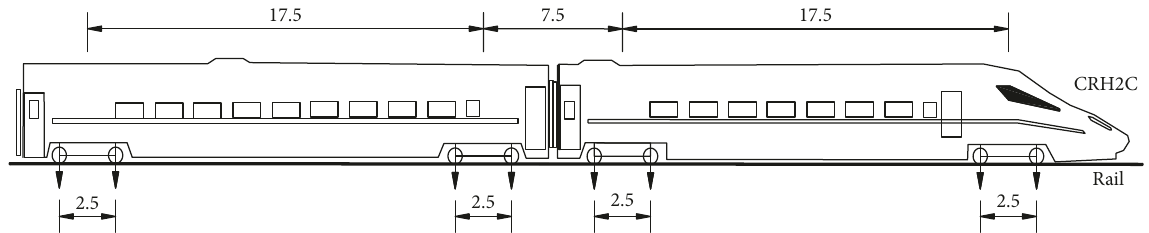
Figure 4: The key dimension parameters of the high-speed train moving on the on-site test section (units in